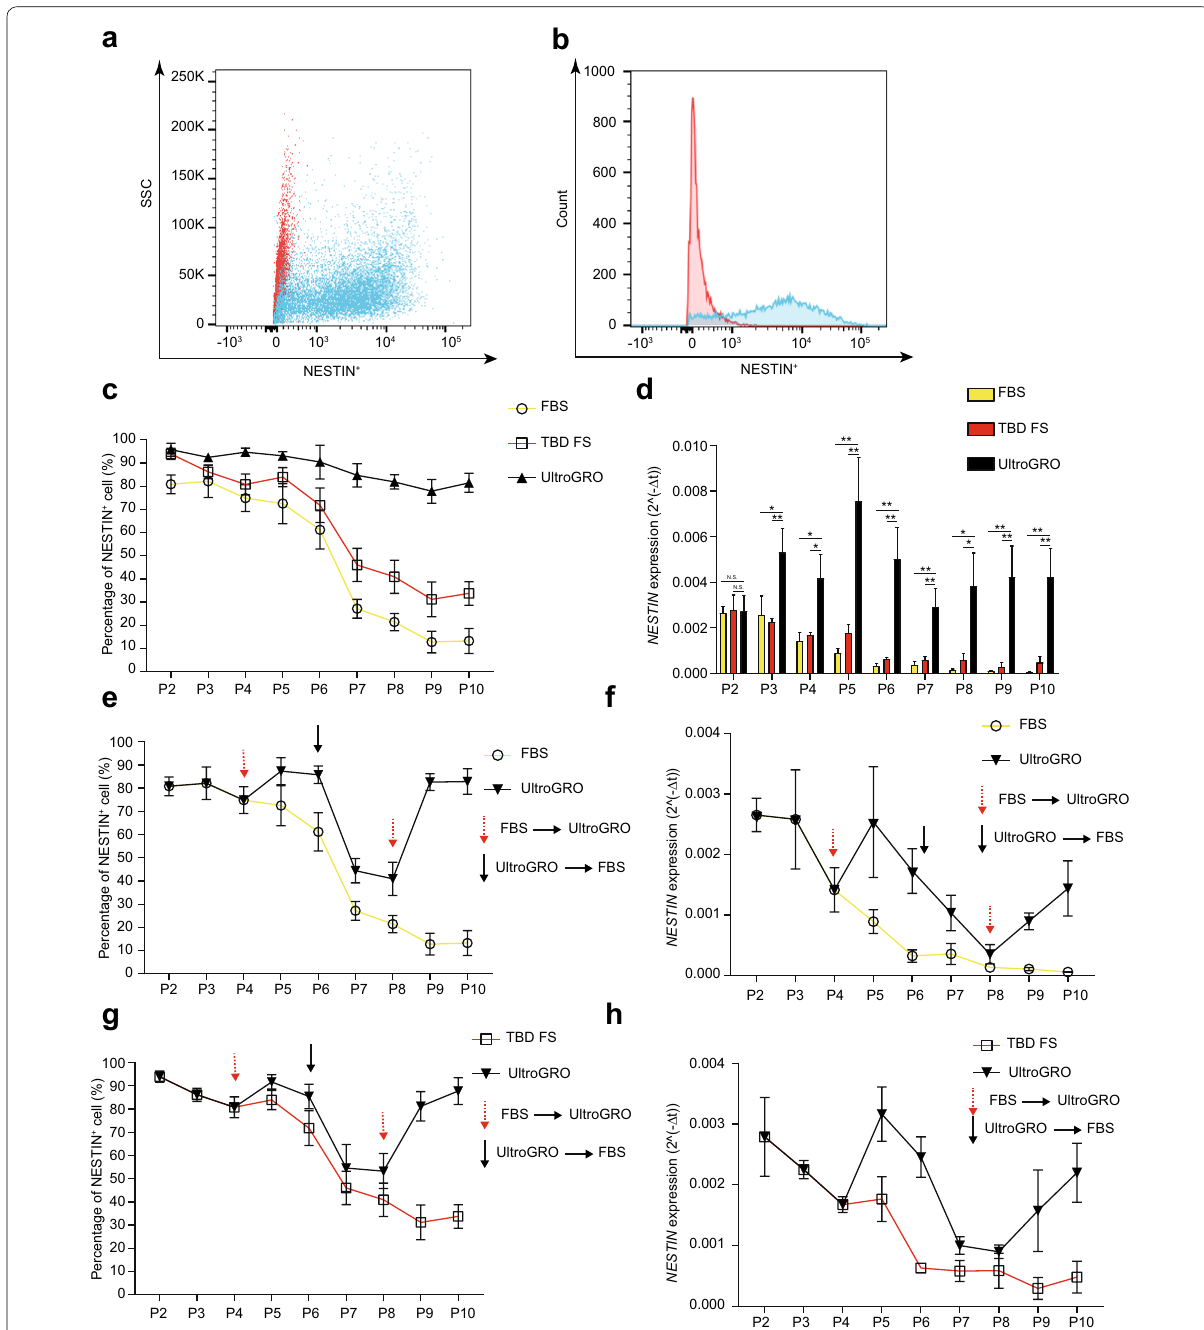
Fig. 2 The expression of NESTIN in three different culture conditions. a , b The flow cytometry analysis of NESTIN in UC-MSCs. c The percentage of NESTIN + cells in three culture conditions. d The expression level of NESTIN in three culture conditions. e – h The percentage of NESTIN + cells and expression level of NESTIN after changing the medium. **p < 0.01, * p < 0.05, Student’s t -test. For all experiments, n data shown are mean ±